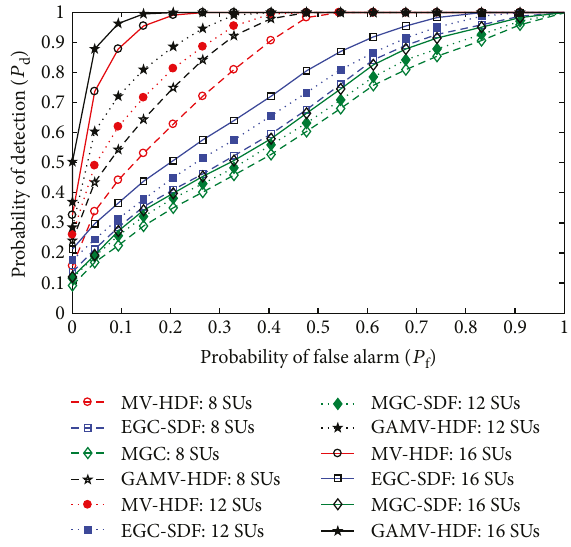
Figure 7: Probability of detection versus probability of false alarm (ROC) at di ff erent ratios of cooperating SUs with MUs having high SNR compared with